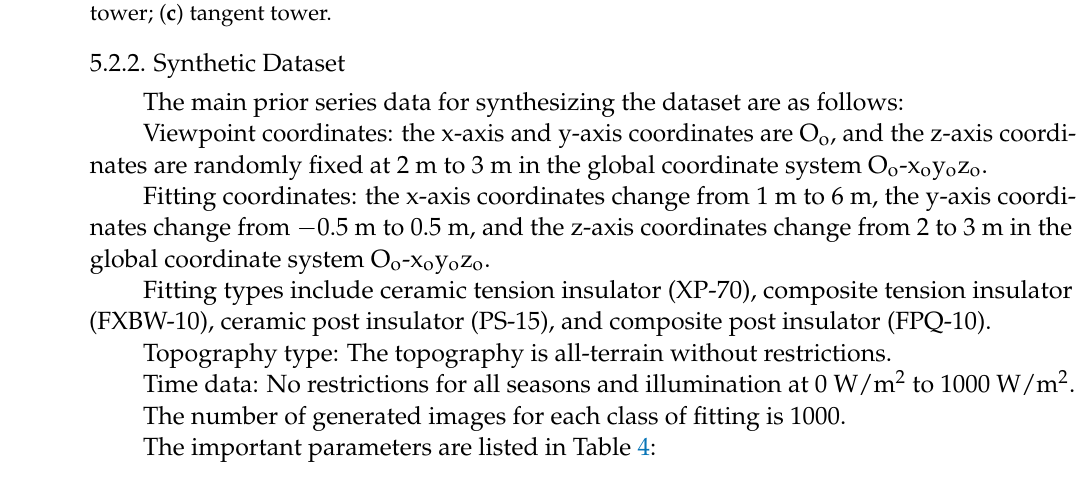
Figure 17. Schematic diagram of the line field experiment. ( a ) Overall diagram of the line; ( b ) tension tower; ( c ) tangent tower.